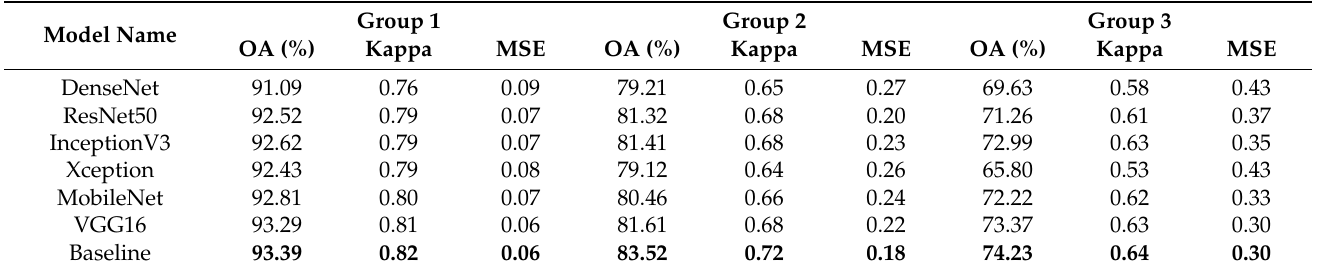
Table 6. The quantitative comparison of different baseline models for classification of building damage in the Ludian